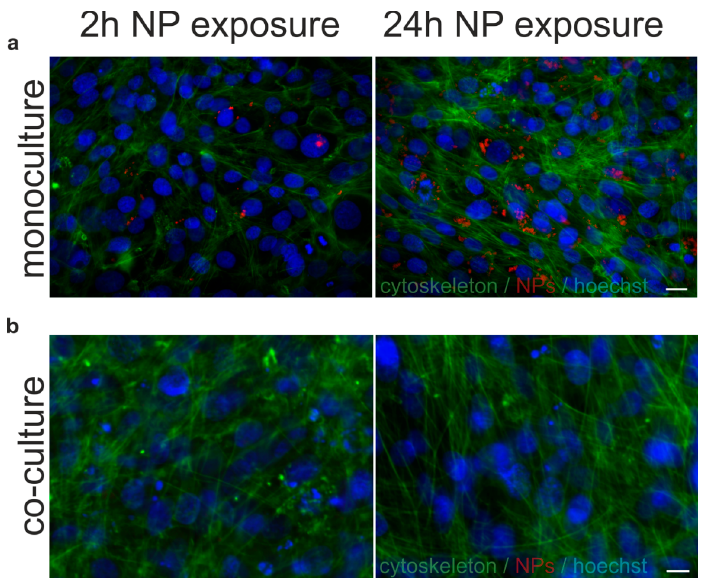
Figure A2. Pericytes in the monoculture model ( a ) and in the co-culture model ( b ). Representative microscopic images show pericytes internalizing nanoparticles (NPs) (red) in the monoculture model after both 2 h and 24 h exposure, while no NPs internalization can be observed in the co-culture model. The cytoskeleton marker is shown (green). Scale bars: 10 µ m. Cell nuclei were counterstained with Hoechst (blue). Int. J. Mol. Sci. 2021 , 22 , x FOR PEER REVIEW